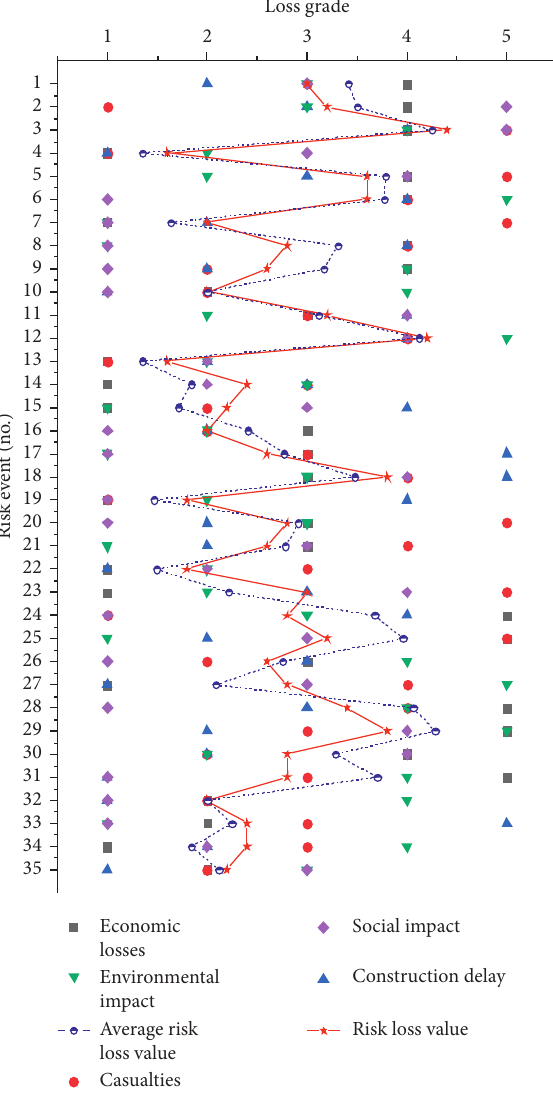
Figure 6: Scores of the loss indicators for each risk event. Table 9: Expert indicator score.